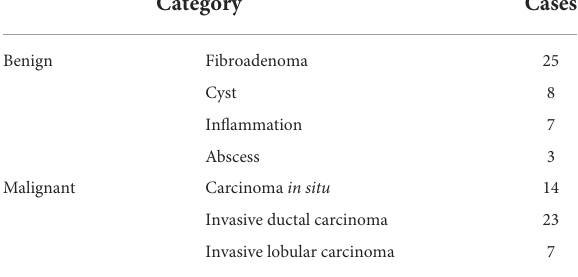
TABLE 1 Statistics of the